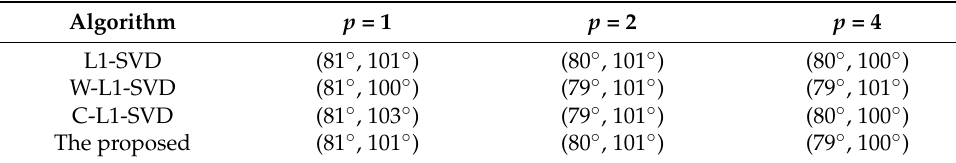
Figure 6. Sensitivity of the 4 algorithms to the assumed number of signals: ( a ) L1-SVD; ( b )W-L1-SVD; ( c ) C-L1-SVD; ( d ) the proposed algorithm. Table 4. DOA estimates in Figure 6.